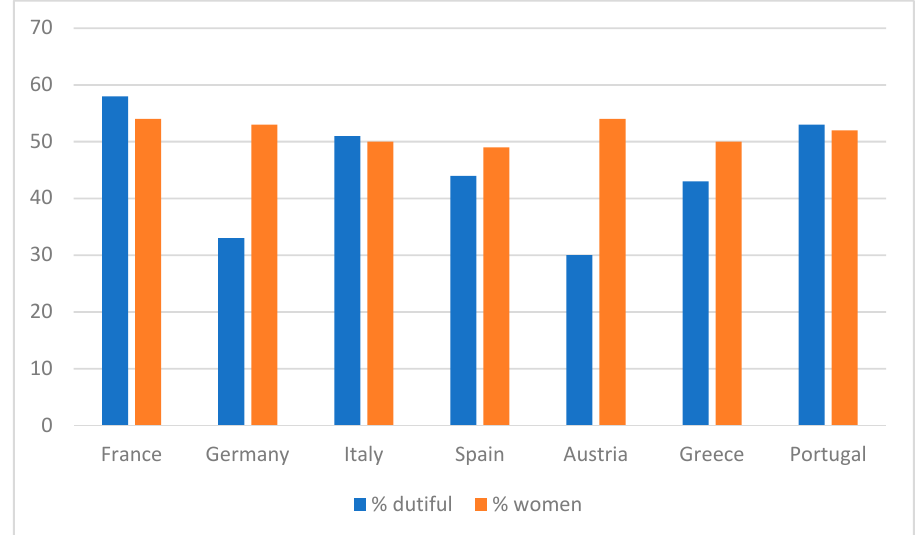
Table 1. Percent of dutiful citizens and women per country (CEESP).